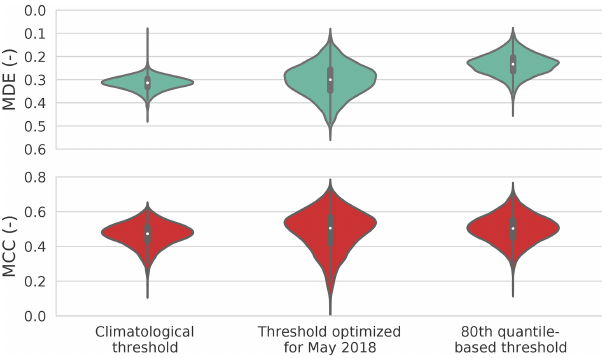
Figure 4. Mean detection error (MDE) and the Matthews correla- tion coefficient (MCC) for three rain event detection schemes for the whole analysis